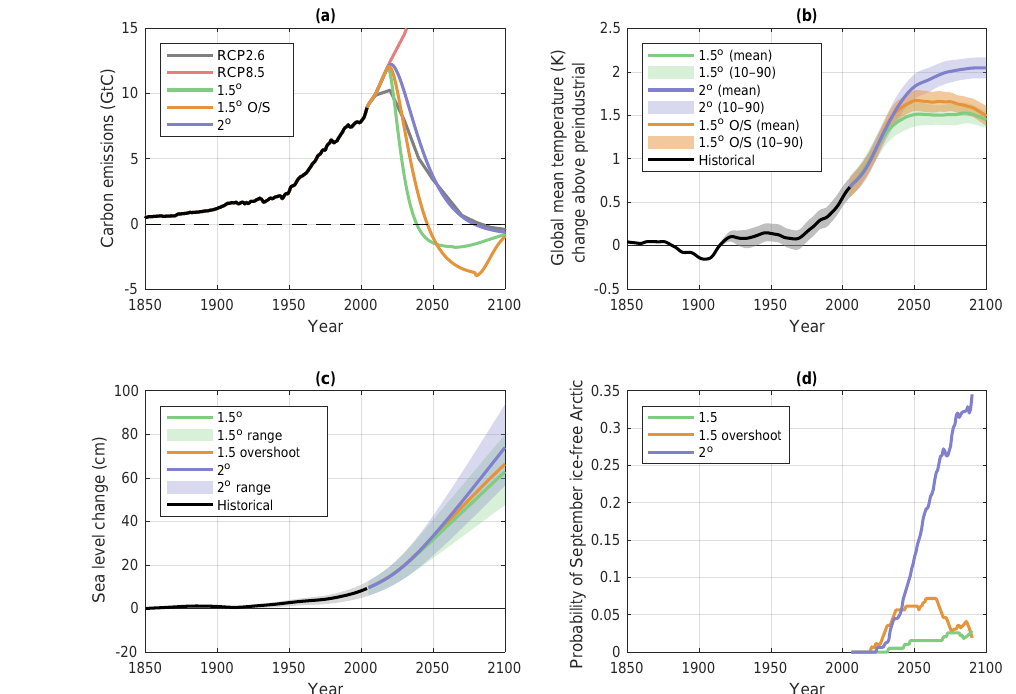
Figure 1. Results from the CESM low-emissions scenarios. Panel (a) shows the total carbon emissions trajectory (fossil fuel, cement and land use) used to drive the model simulations. Panel (b) shows the range of annual global mean temperatures changes for the three scenarios, 1.5 ◦ C never-exceed (green), 1.5 ◦ C overshoot (orange) and 2.0 ◦ C (purple). Lines are the most likely values, while the shaded areas are the 10–90% expected range in the CESM ensemble. Panel (c) shows the corresponding sea level rise using global mean temperature relationships from Kopp et al. (2016) and (d) shows the annual likelihood derived from the CESM ensembles that the Arctic will be ice-free in September (20-year running mean).